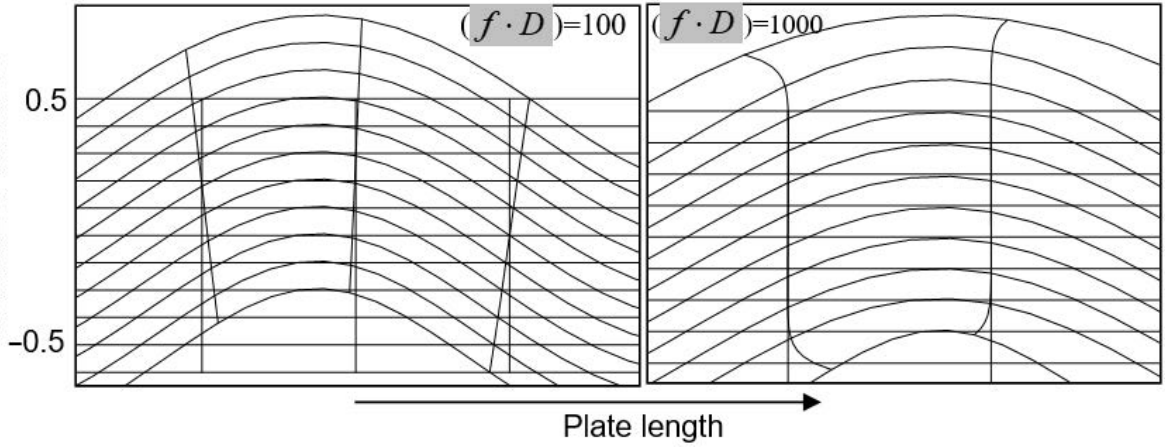
Figure 4. Displacement patterns for a 0 modes for different frequencies and various ( f · D ) in